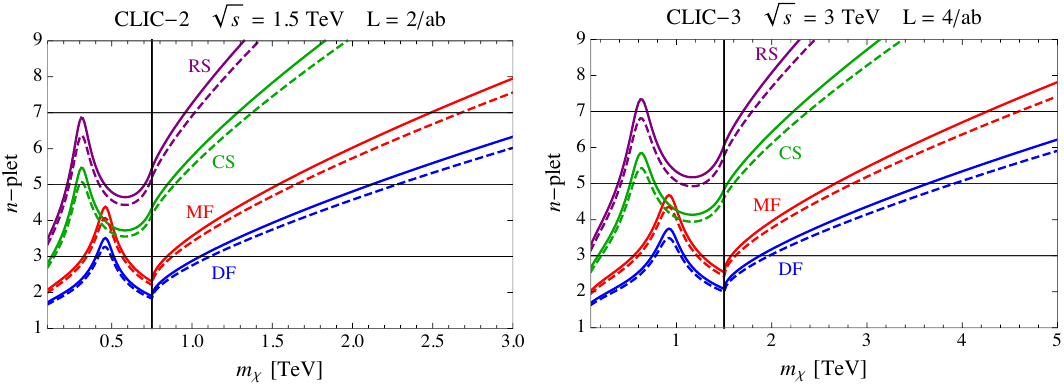
Figure 7 . Expected 95% CL exclusion limits for CLIC-2 (left panel) and CLIC-3 (right panel), for di(cid:11)erent Lorentz representations and polarization fractions ( P ( P ; P ) = ( (cid:0) 80% ; +30%) [dashed e (cid:0) e +